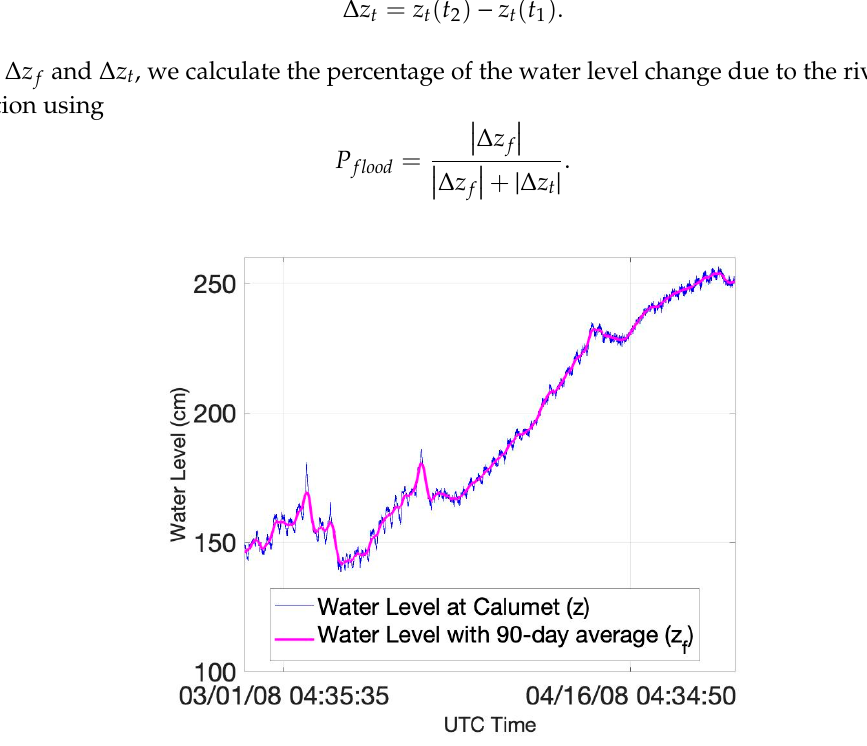
Figure 16. Time series water level height (fast-changing) and estimated flooding height (slow-changing) at the Calumet water level gauge (USGS 07381590). The time period covers two PALSAR acquisitions, 2008.3.1 and 2008.4.16.